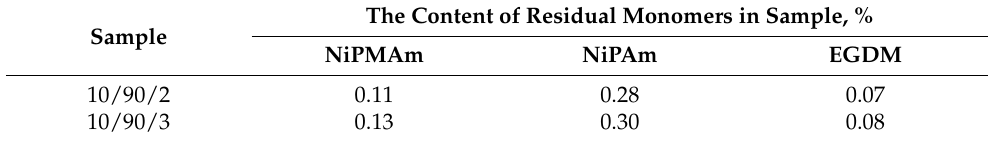
Table 2. The content of residual monomers in synthesized p(NiPMAm/NiPAm) hydrogels.